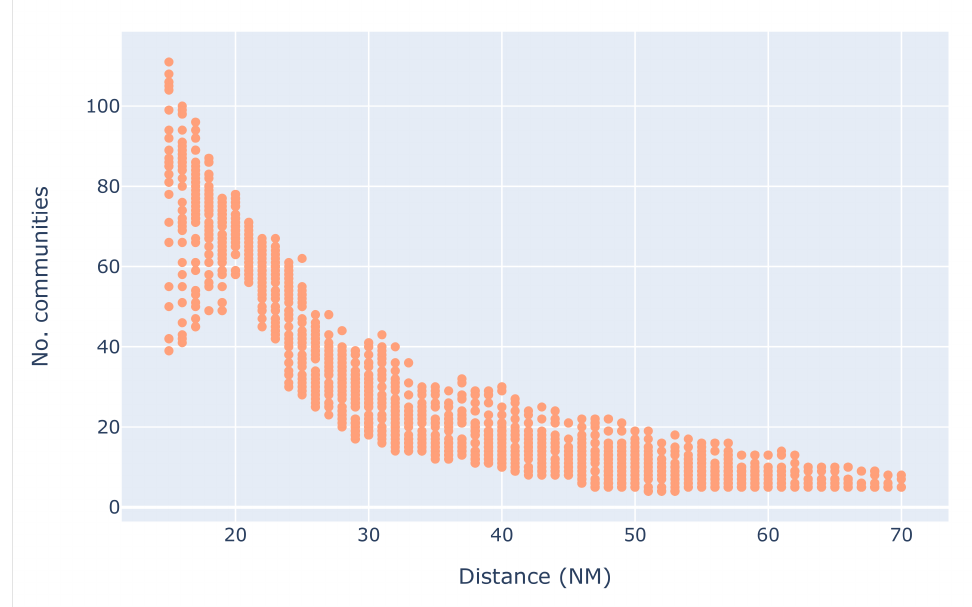
Figure 25. Number of communities for different distance thresholds.